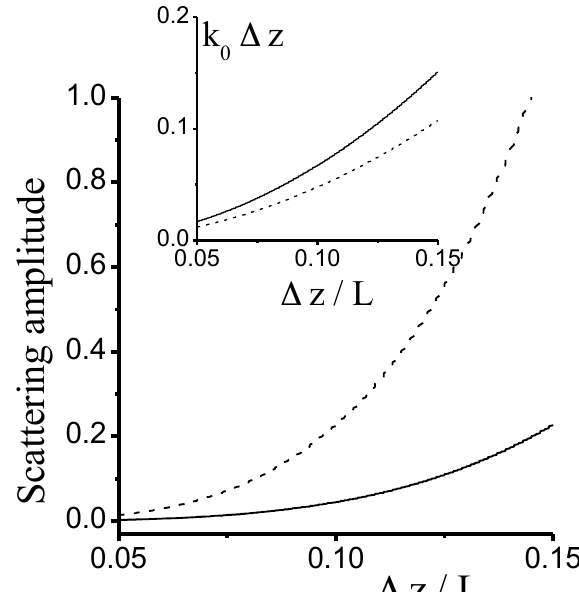
Figure 4: Calculated resonance scattering amplitude (9) versus the